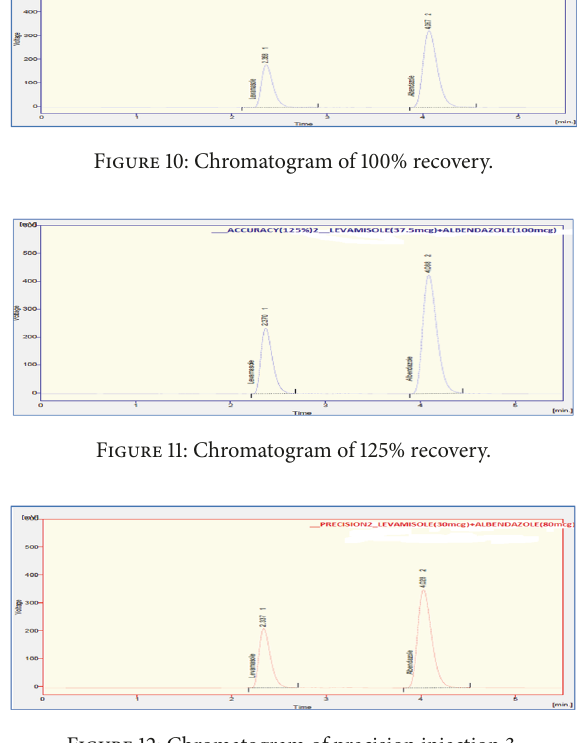
Figure 12: Chromatogram of precision injection 3.